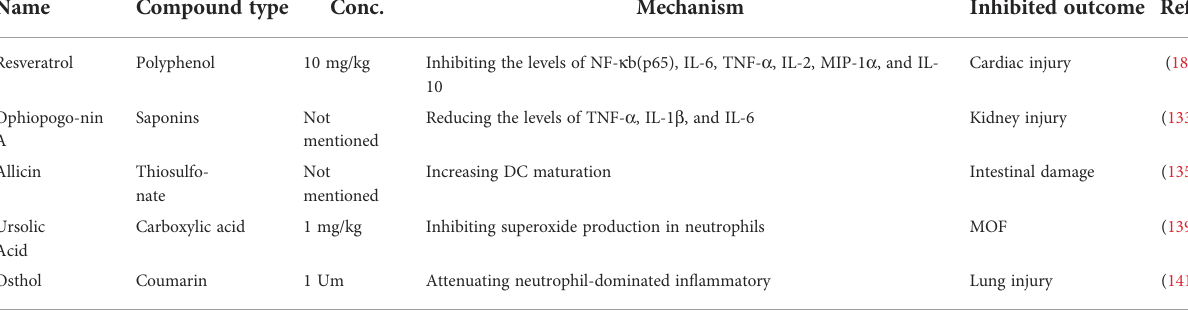
TABLE 4 Overview of the applications of natural medicine therapy in a hemorrhagic shock